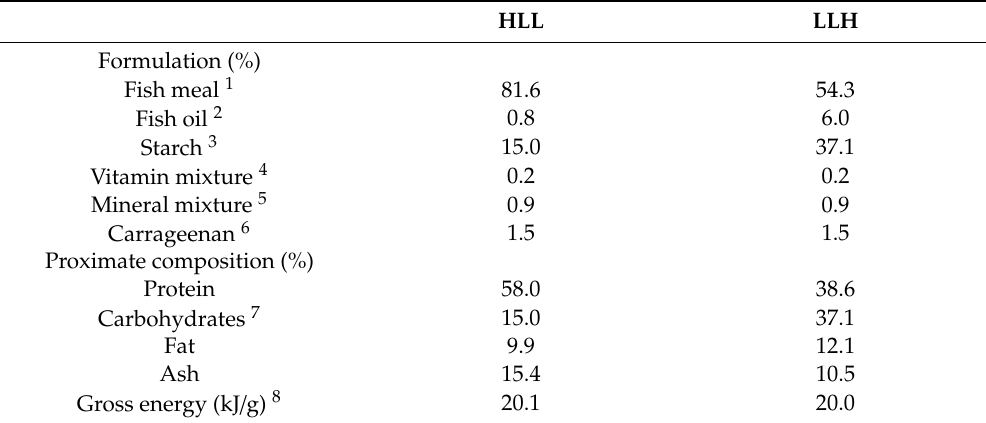
Table 1. Composition of the diets supplied in this study to S. aurata